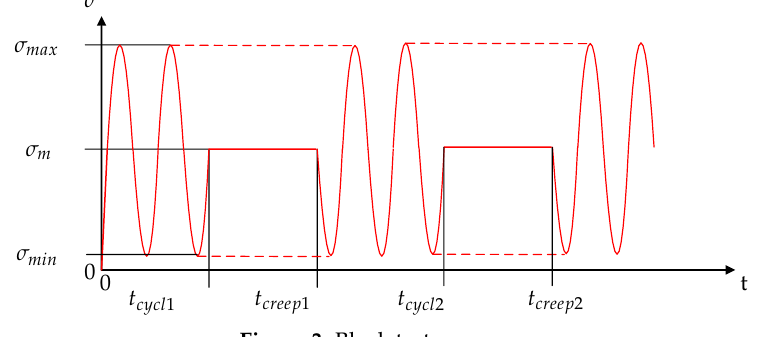
Figure 3. Block test